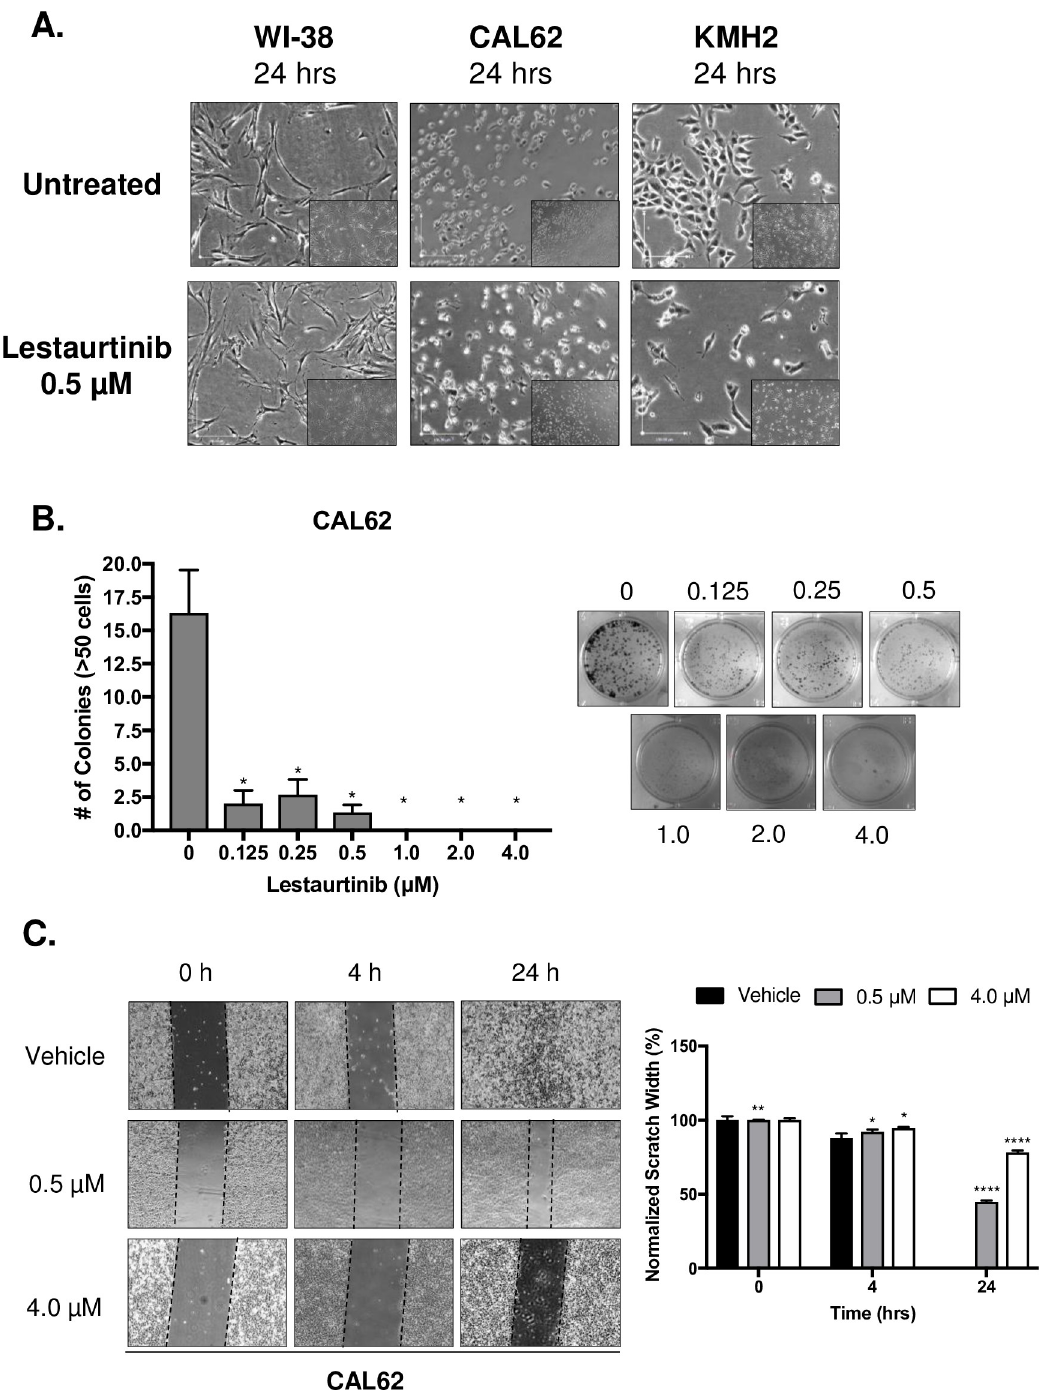
Fig 2. Treatment of ATC cell lines with Lestaurtinib resulted in an antiproliferative effect, in vitro . (A) Phase contrast images of WI-38, CAL62 and KMH2 cell lines with and without Lestaurtinib treatment (0.5 μ M; 4X magnification). (B) Clonogenic assay of CAL62 both untreated and treated with increasing concentrations of Lestaurtinib (0.125–4 μ M) and stained with 0.5% crystal violet. Colony formation was quantified by counting colonies from 3 representative fields, with colonies defined as being � 50 cells. (C) Scratch-wound assay of CAL62 cells treated with 0.5 and 4.0 μ M Lestaurtinib at 0, 4 and 24 h. Ten measurements were taken across the width of the scratch and averaged (3 replicates per cell line) per time point. � represents p < 0.05, �� represents p < 0.01, ��� represents p < 0.001, ���� represents p < 0.0001, ns = not significant, Student’s unpaired, two-tail t -test.